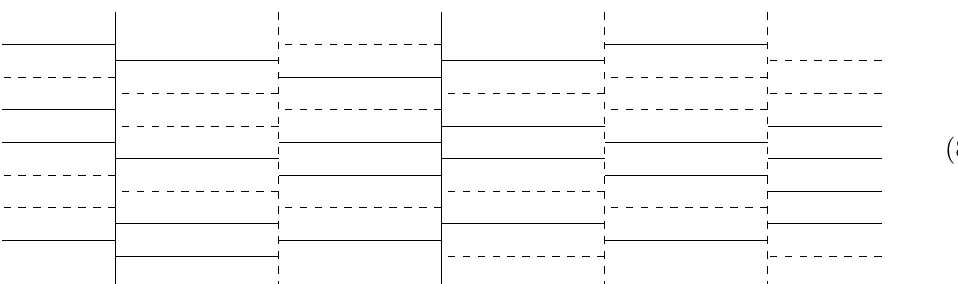
The dashed horizontal lines correspond to the representations like (0 , − 1) vertical lines correspond to the representations like ( − 1 , n ) should correspond to negative NS5-branes and level ( − 1 , n ) should correspond to a bound state of negative NS5-brane and D5-branes with charge (0 , n )